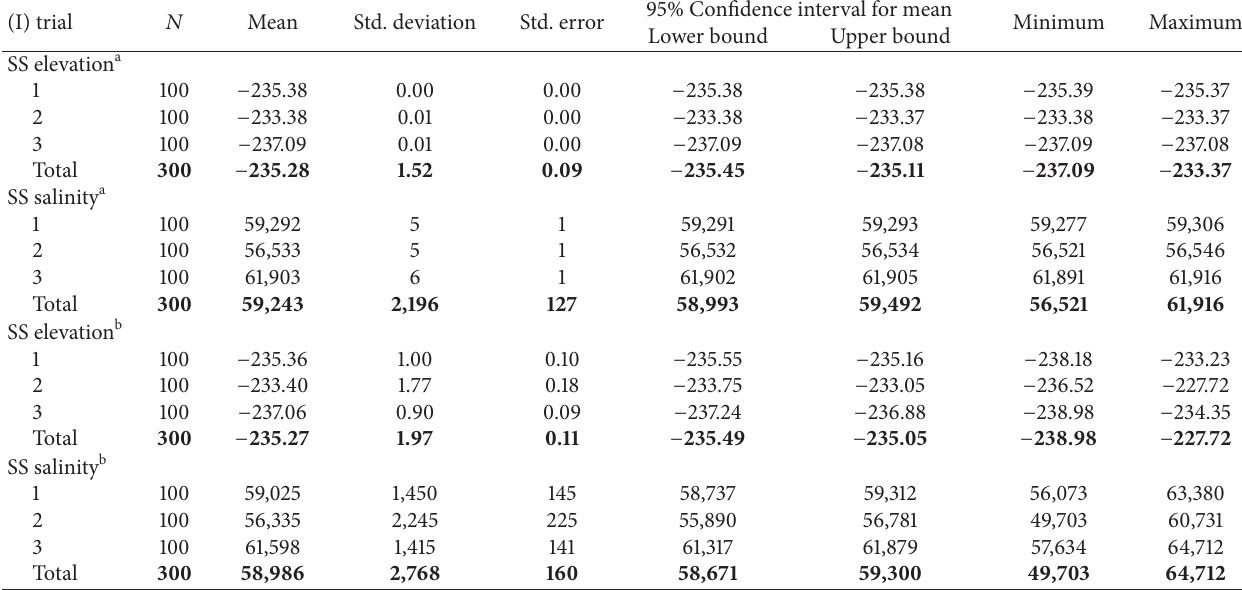
Table 4: Salton Sea (SS) climate sensitivity analysis: one-way ANOVA descriptives.